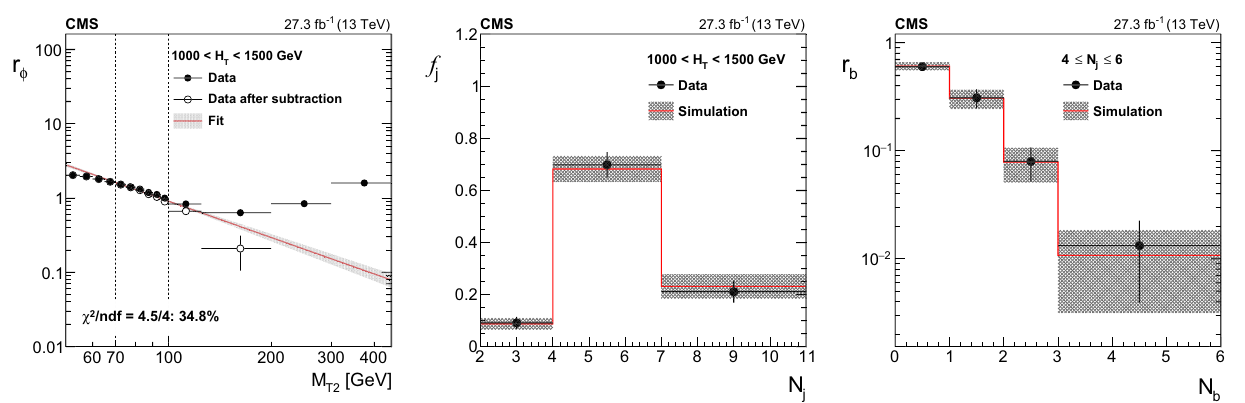
Fig. 3 The ratio r φ as a function of M T2 for 1000 < H T < 1500GeV (left). The superimposed fit is performed to the open circle data points. The black points represent the data before subtracting non-multijet con- tributions using simulation. Data point uncertainties are statistical only. The red line and the grey band around it show the result of the fit to a power-law function performed in the window 70 < M T2 < 100GeV